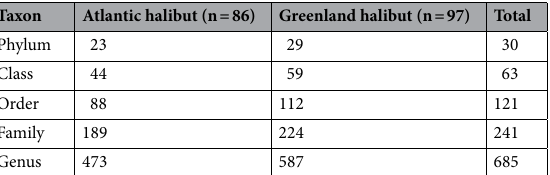
Table 2. Number of taxa in the cmDNA of the Atlantic halibut ( H. hippoglossus ) and the Greenland halibut ( R. hippoglossoides